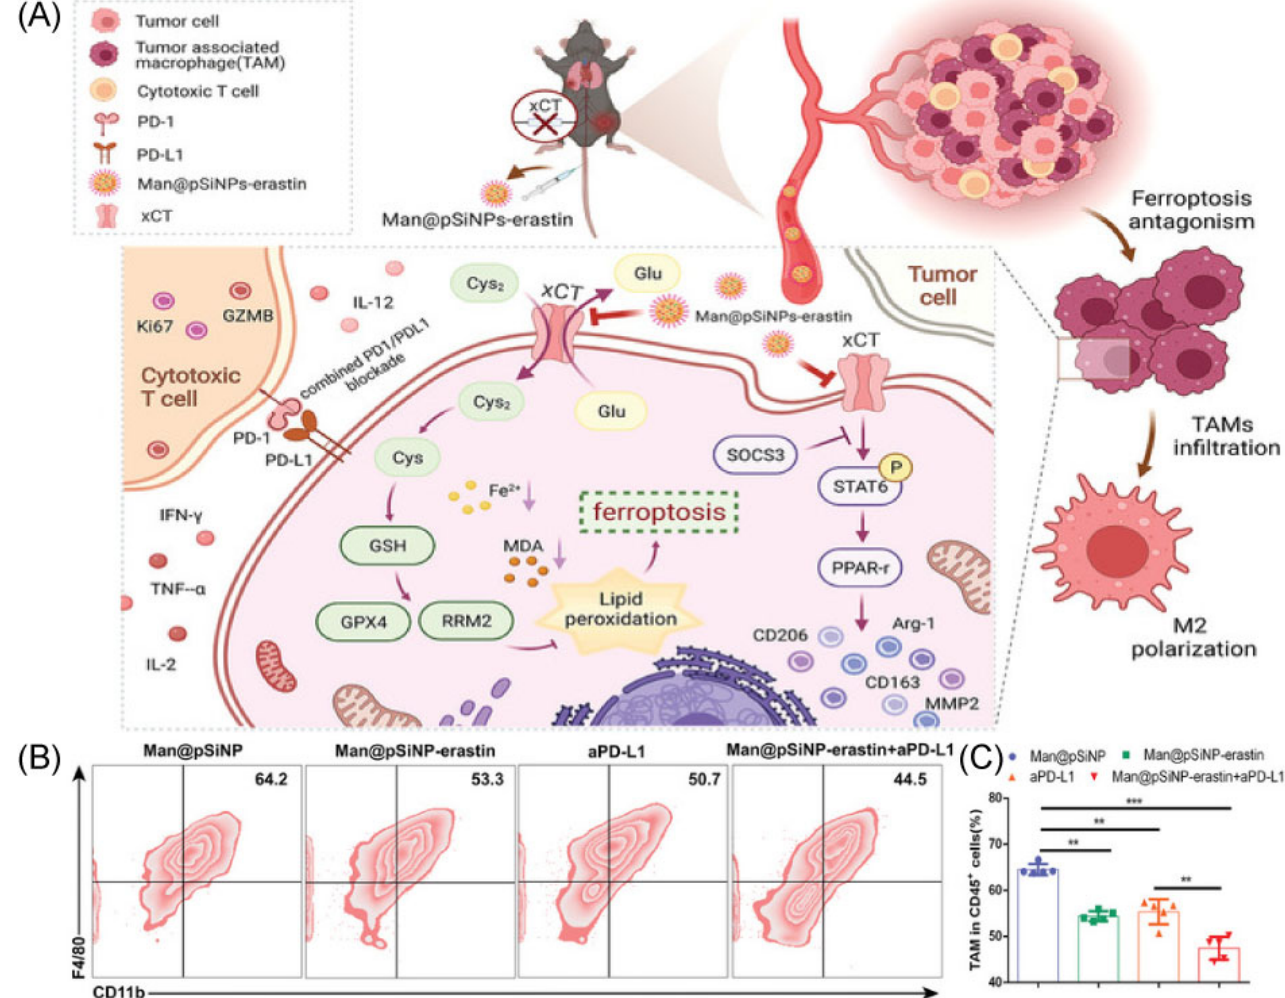
Figure 3. ( A ) The mechanism with Man@pSiNPs-erastin induced ferroptosis and polarization of macrophages. ( B , C ) Flow cytometry data shows the percent of TAMs in tumor tissues in response to different groups ( n = 5). ** p < 0.01, *** p < 0.001. Copyright 2022, Wiley-VCH GmbH